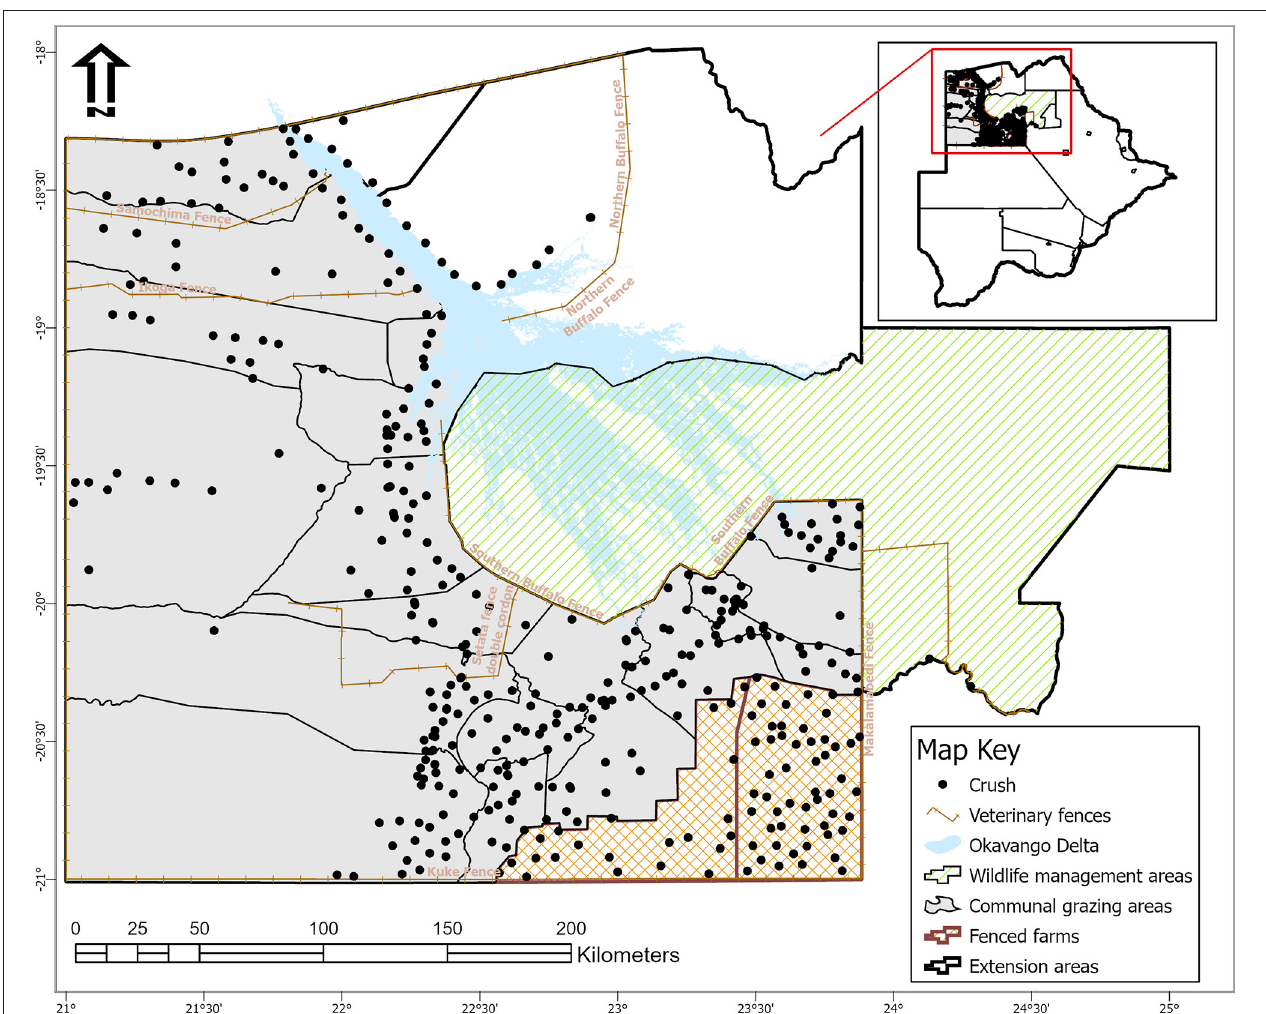
FIGURE 2 | Map of Ngamiland abattoir catchment areas showing location of veterinary fences, crushes, and their spatial relation to wildlife management areas [Source: Adapted from the Department of Veterinary Services’ Veterinary Epidemiology and Economic Section (VEES), Botswana, 2020].